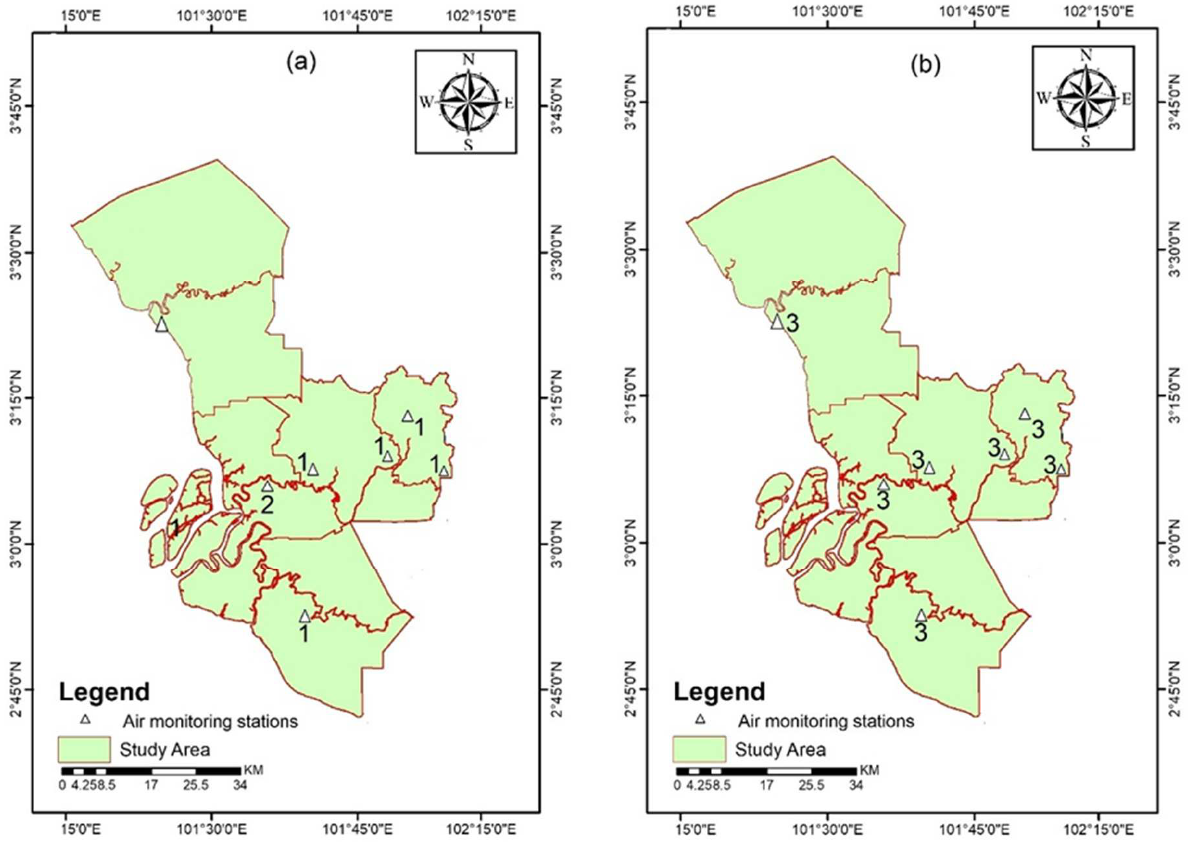
Figure 5. The optimum order of the MC model for the simulated ( a ) hourly and ( b ) daily API.